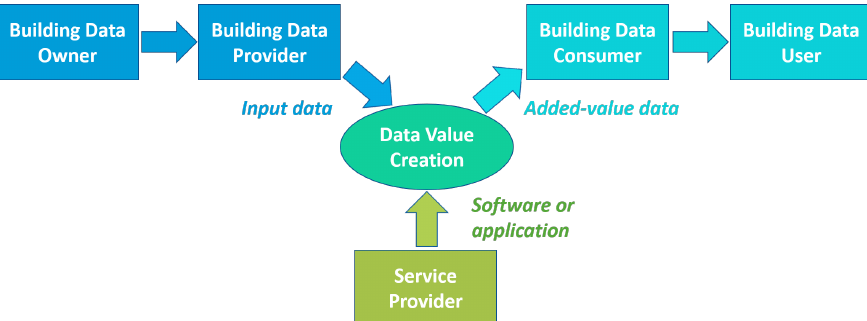
Figure 2. Stakeholders’ roles within the building data value